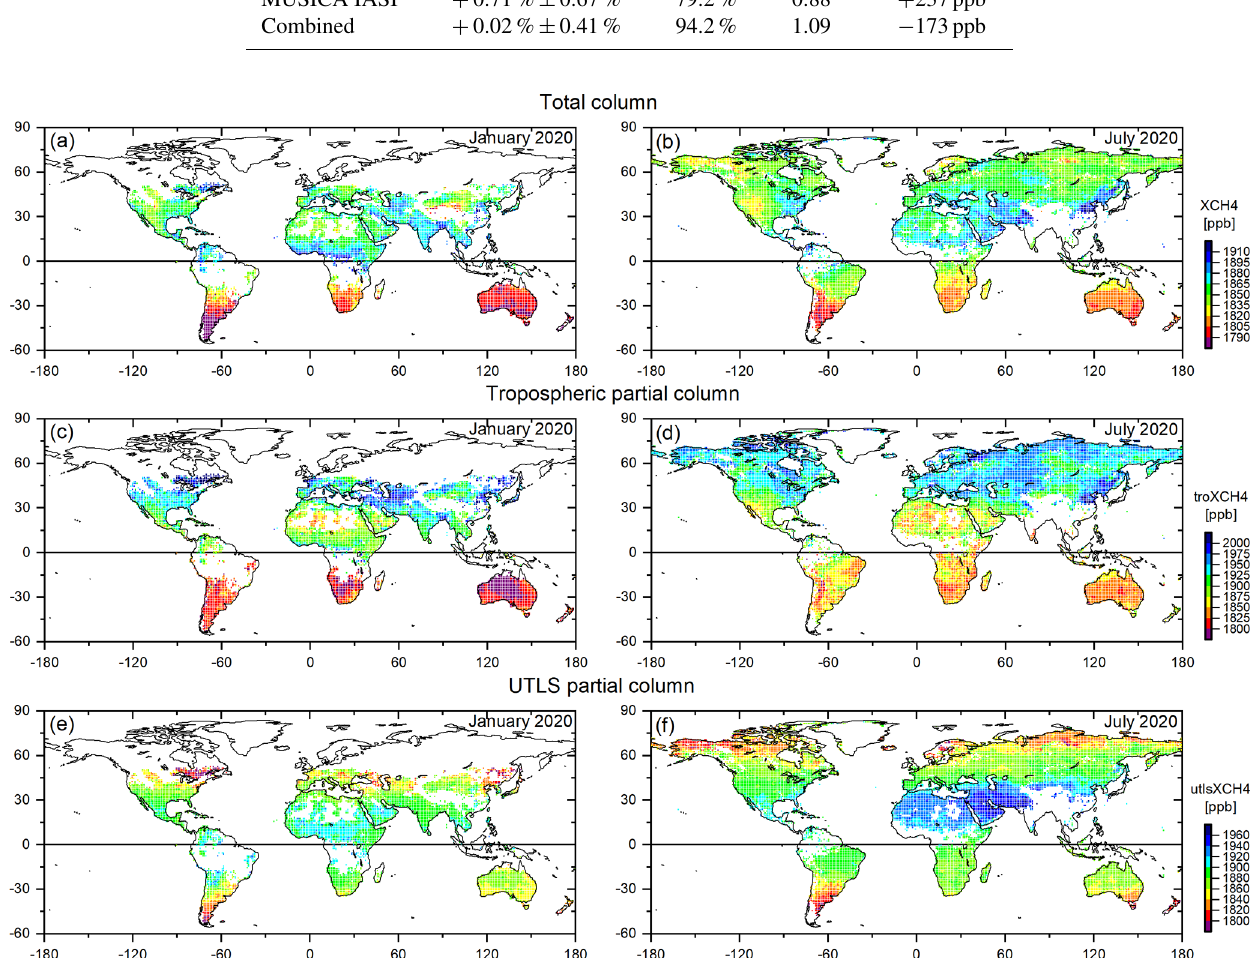
Figure 15. Global maps with 1 ◦ × 1 ◦ (longitude × latitude) resolution of monthly mean data for January and July 2020. (a, b) XCH 4 as observed by TROPOMI. (c, d) Tropospheric partial columns of CH 4 as obtained by the combined product. (e, f) UTLS partial columns of CH 4 as obtained by the combined